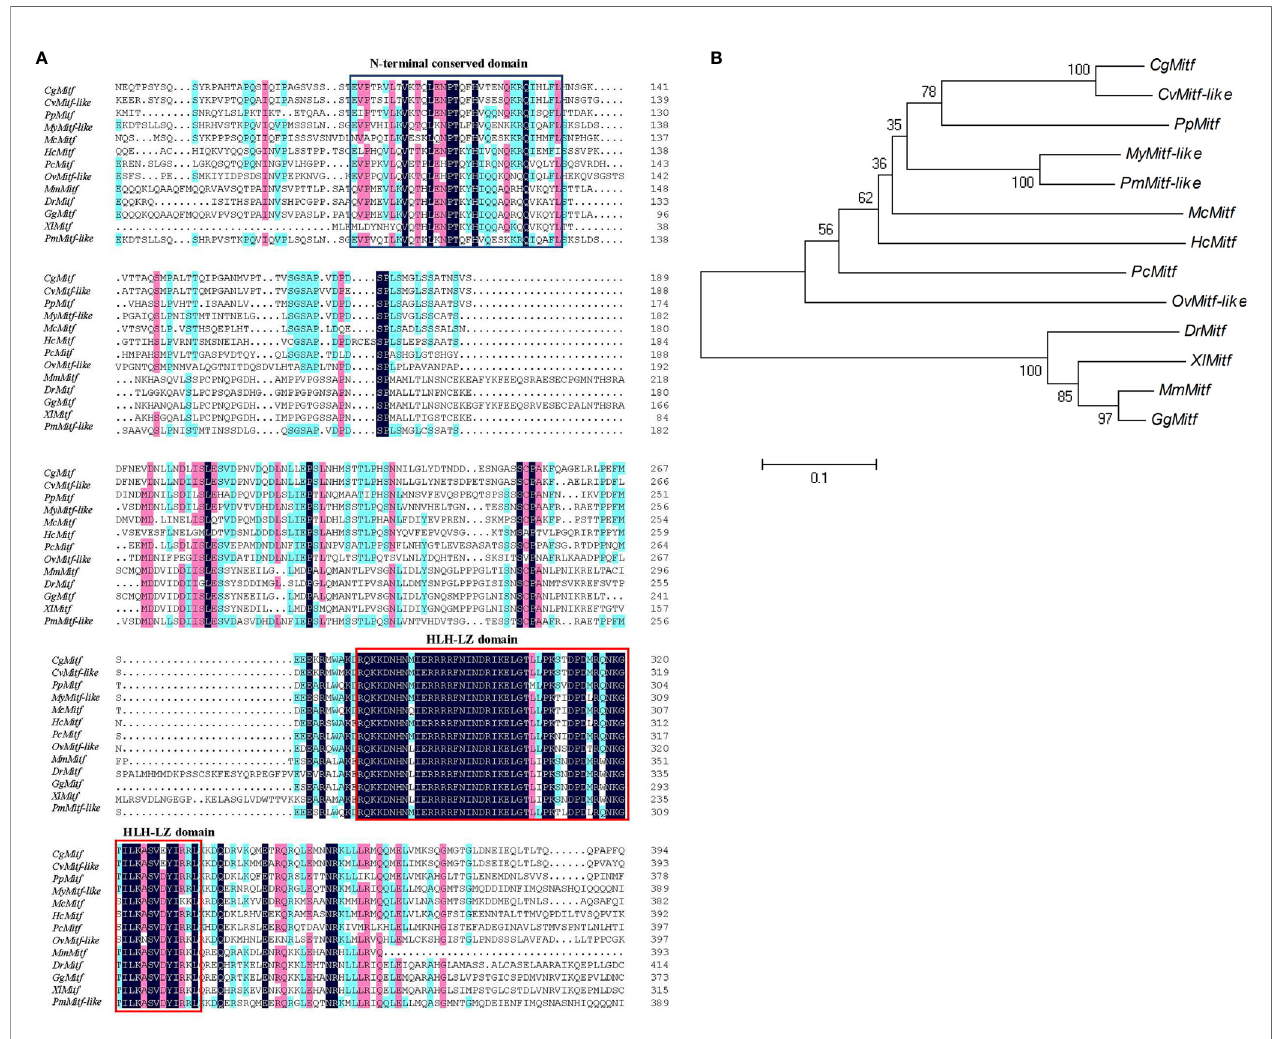
FIGURE 2 | Sequence alignment and phylogenetic analysis. (A) Multiple sequence comparison of Mitf amino acid sequences in various species, including Pteria penguin ( PpMitf , MN296415), Crassostrea gigas ( CgMitf , XP_011447560.2), Crassostrea virginica ( CvMitf-like , XP_022298291.1), Mizuhopecten yessoensis ( MyMitf- like , XP_021364176.1), Pecten maximus ( PmMitf-like , XP_033745263.1), Mytilus coruscus ( McMitf , CAC5409749.1), Hyriopsis cumingii ( HcMitf , QBG58751.1), Pomacea canaliculata ( PcMitf , XP_025106304.1), Octopus vulgaris ( OvMitf-like , XP_029634800.1), Danio rerio ( DrMitf , NP_571922.2), Xenopus laevis ( XlMitf , NP_001165646.1), Gallus gallus ( GgMitf , BAA25648.1), Mus musculus ( MsMitf , AAF81266.2). The black background showed highly conserved amino acids, the green and pink background showed similar amino acids. HLH-LZ domain was boxed in red, and N-terminal conserved domain was boxed in blue. (B) Phylogenetic tree of Mitf genes. The phylogenetic tree was constructed using neighbor-joining method. Numbers at the nodes represented the bootstrap values determined by bootstrap analysis of 1,000 replicates. The scale bar indicated the number of amino acid substitutions per